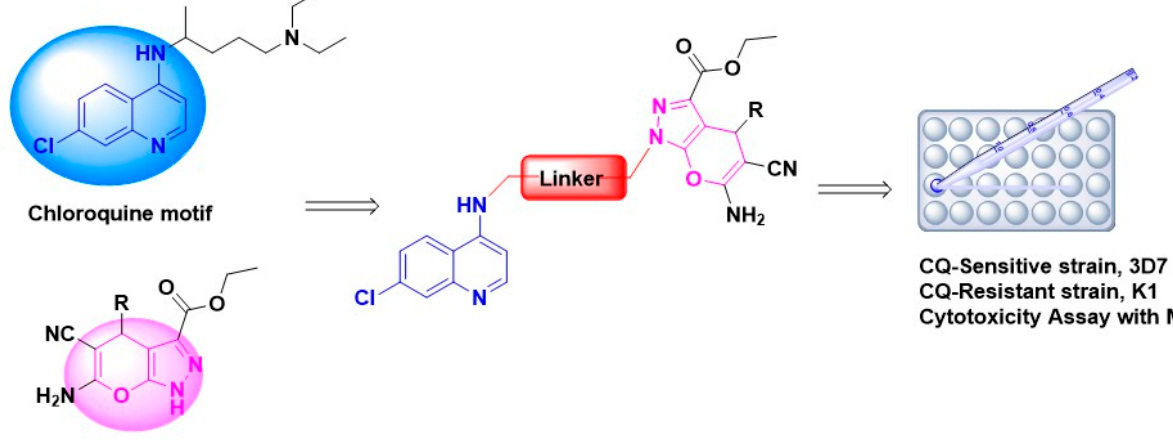
Figure 2. The component of hybrid compounds comprised of chloroquine motif (in blue) and pyrano[2,3-c]pyrazole moiety (in pink).